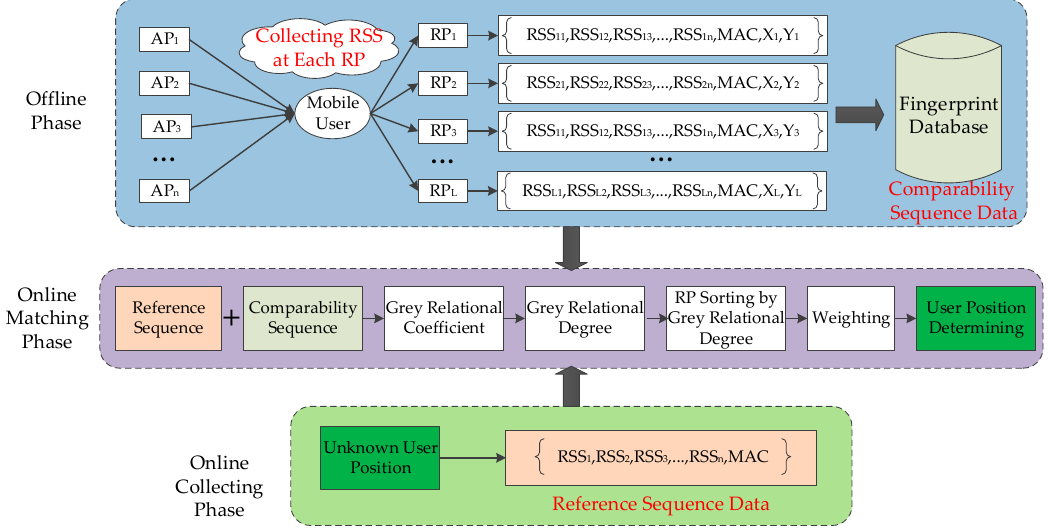
Figure 4. Overview of the fingerprint positioning method based on grey relational analysis.